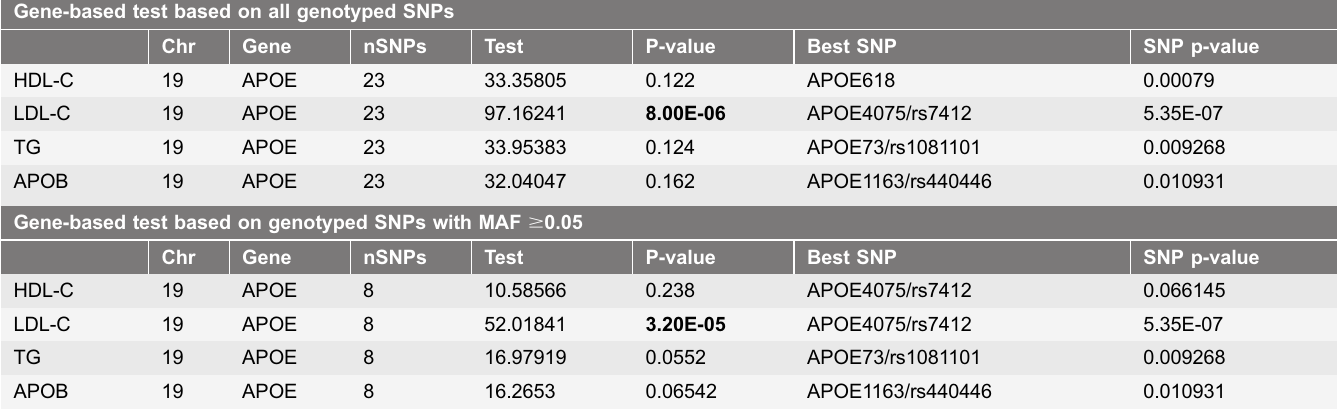
Table 4. Gene-based association analysis with lipid traits in African Blacks. Gene-based test based on all genotyped SNPs